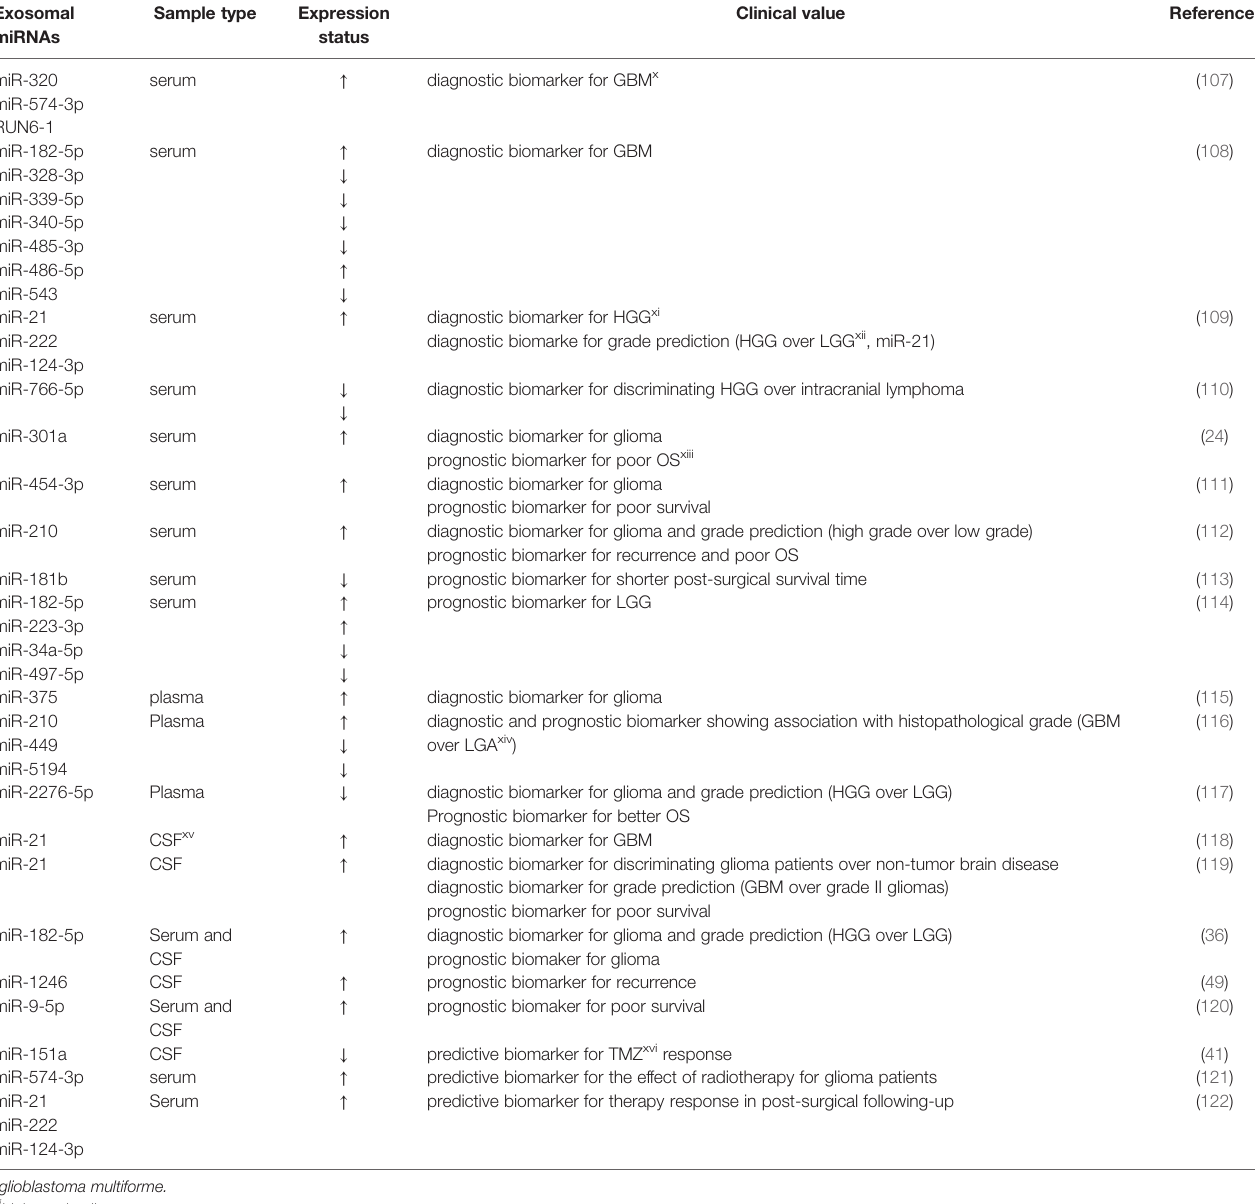
TABLE 2 | Related studies about exosomal miRNAs from human fl uids as diagnostic, prognostic and predictive biomarkers in glioma. Exosomal Sample miRNAs